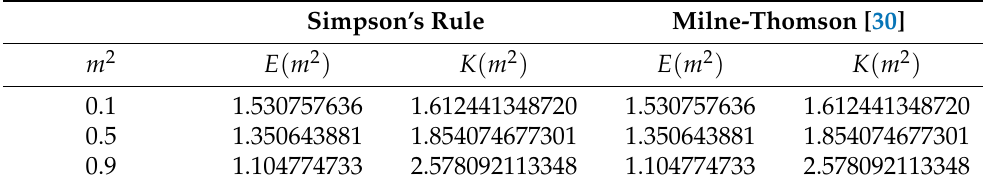
Table 4. Validation of numerical integration of Legendre complete elliptic integrals.